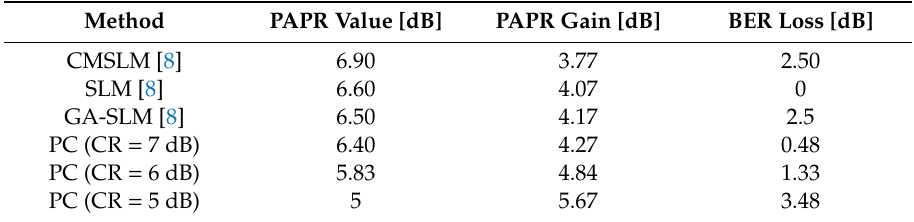
Table 5. Comparative peak-to-average power ratio (PAPR) gain at CCDF = 10 − 3 and BER loss at 10 − 3 with the PC method and Selective Mapping Technique (SLM) variants. CMSLM: conversion matrices Selective Mapping Technique, GA-SLM: Genetic Algorithm Selective Mapping